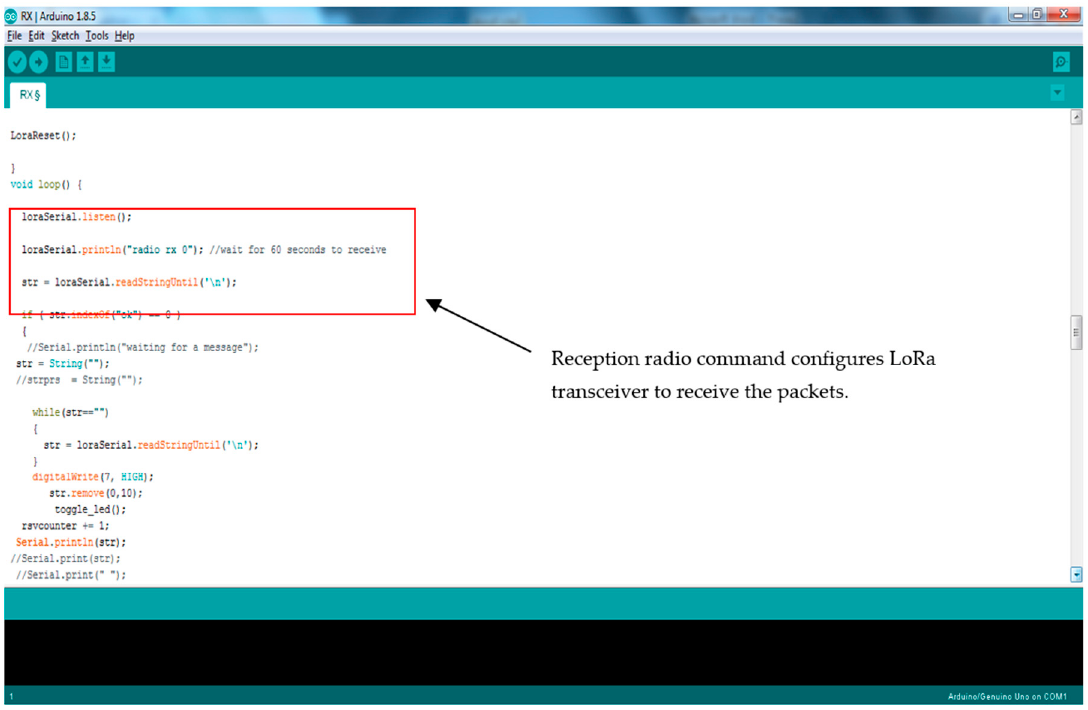
Figure A4. LoRa command preparing the receiver node to listen for incoming data.